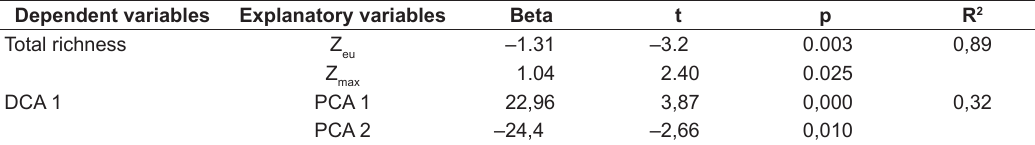
Figure 7. Temporal sequence of the scores of the first axis of the DCA for the floodplain lake demonstrating the changes in the phytoplankton composition. Table 2. Sumary of multiple linear regressions (only significant relationships are